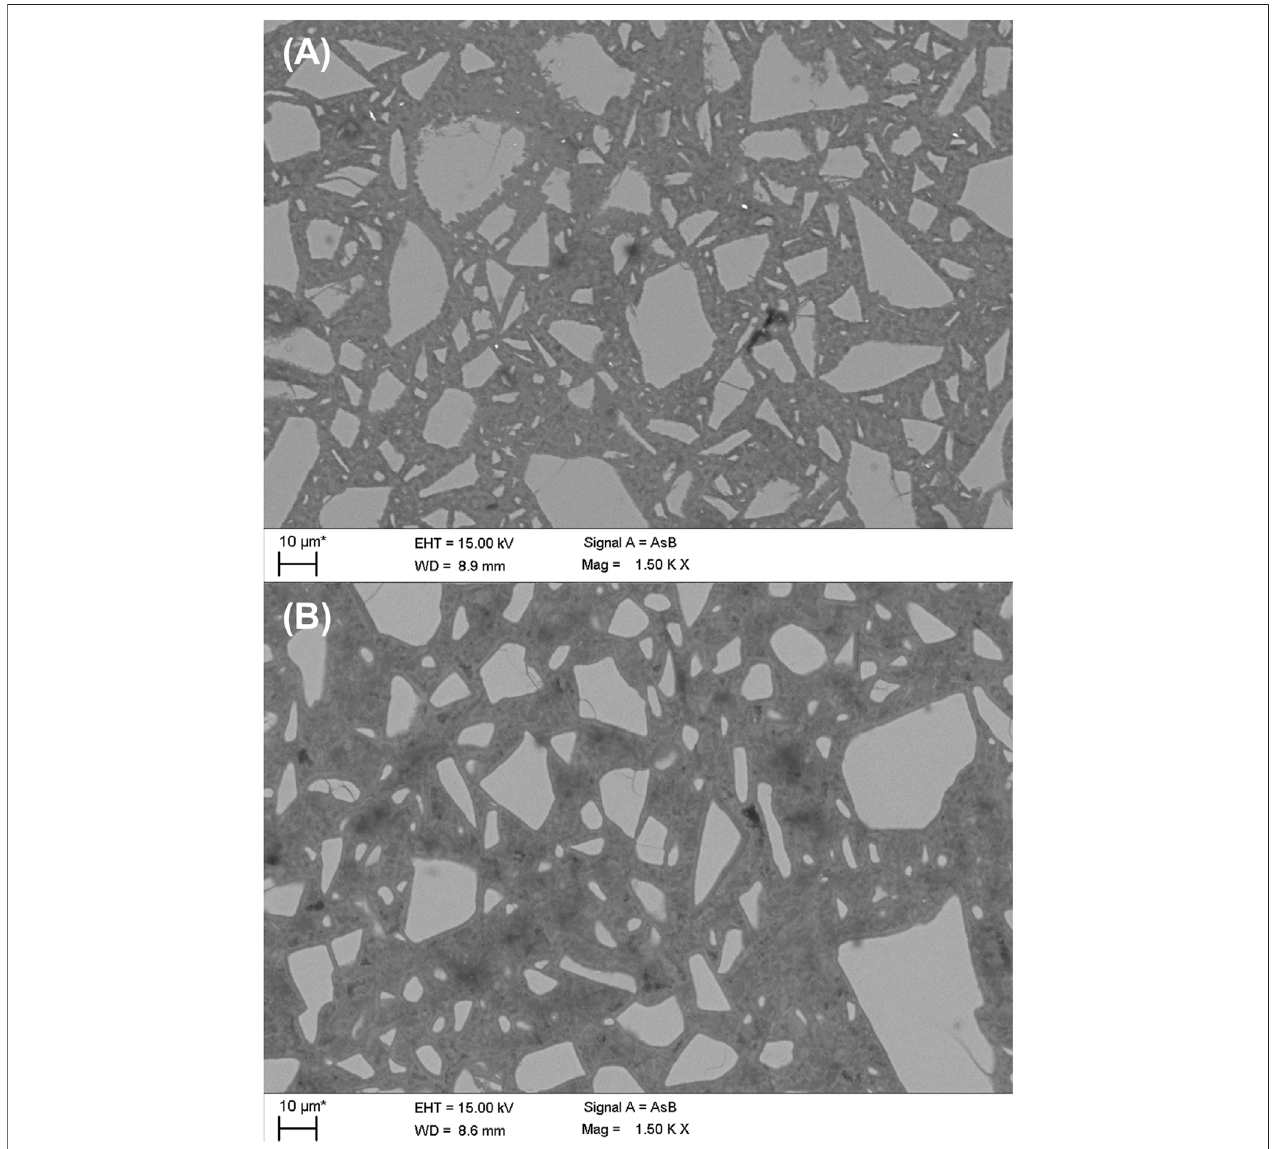
FIGURE 6 | The microstructure of (A) alkali-activated BG in comparison to (B) AAM from GBFS.